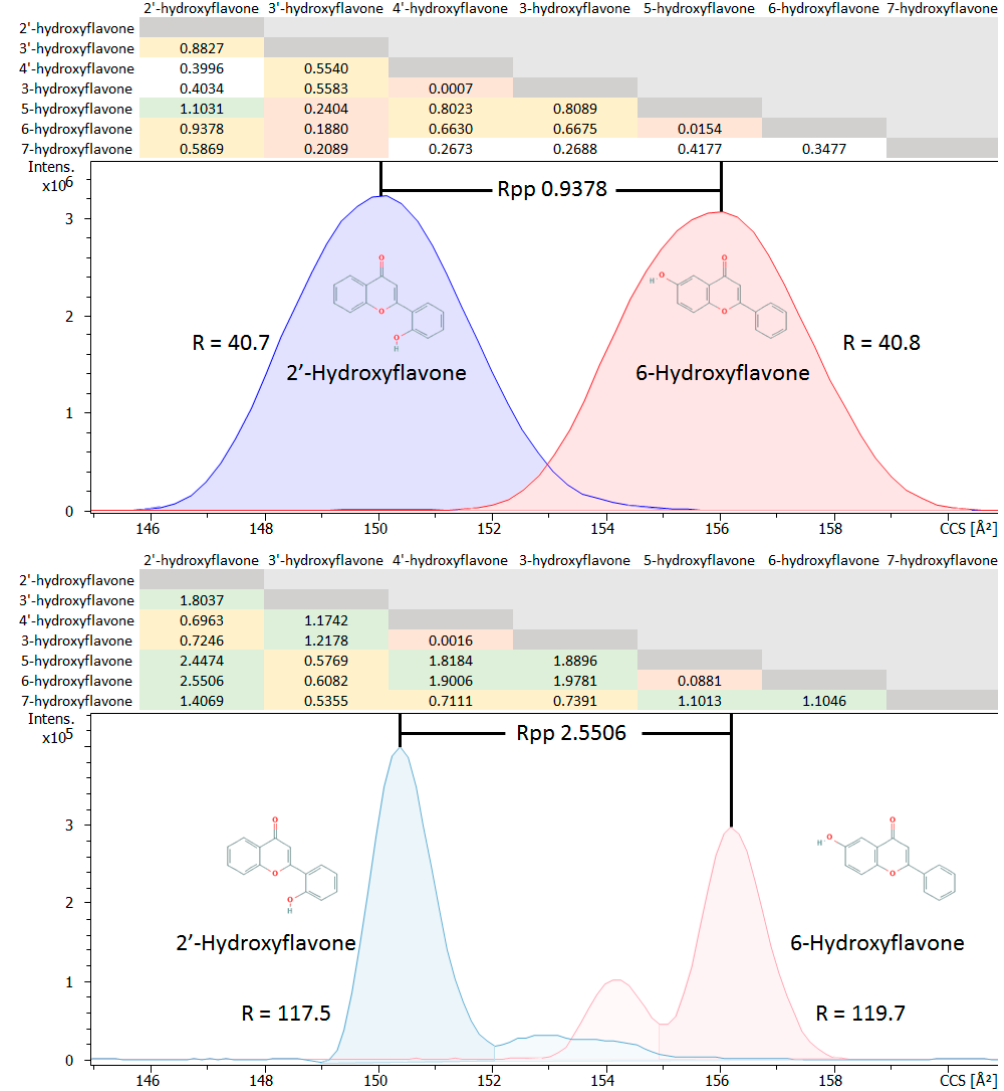
Figure 3. Comparisons of the TIMS resolving power for all combinatorial separations of seven measured isomeric monohydroxyflavones based upon the resolution peak to peak (Rpp) equation from Dodd et al., 2017 [31]. The table shows the calculated R pp for distinguishing CCS values of various isomers monohydroxyflavone pairs using TIMS. Isomer CCS Rpp comparisons are at the intersections of the table’s compound names across the top with the compound names along the left side. Rpp > 1 (green), 1 > Rpp > 0.5 (yellow), 0.5 > Rpp > 0.25 (white), and 0.25 > Rpp > 0 (red). The blue and red traces below the table are extracted ion mobility spectra (EIMs) of 237 m/z and represent the mobilities of 2 ′ -hydroxyflavone and 6-hydroxyflavone respectively. Ten of the 21 possible combinatorial separations of the monohydroxyflavones could be resolved with a Rpp ≥ 0.5 or approximately half height with a TIMS resolution of approximately 40, and 19 of the 21 combinatorial possibilities of the monohydroxyflavones could be resolved with a Rpp ≥ 0.5 and TIMS resolution of ≥